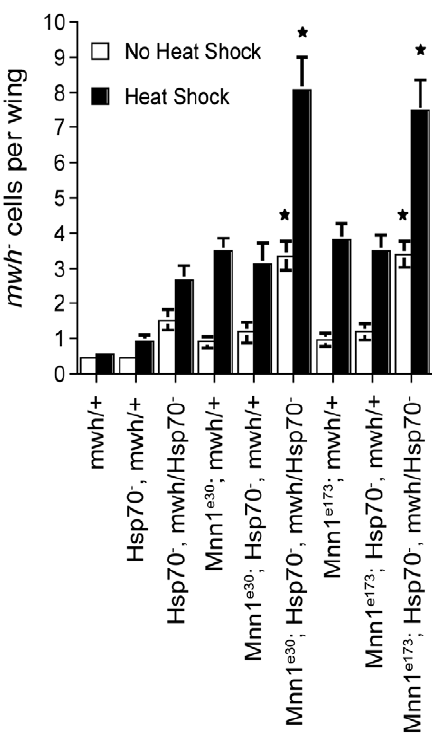
Figure 3. LOH in Mnn1 deletion mutants is not attributable to the disruption of Hsp70 expression. The mwh assay was used to assess genomic instability in Mnn1 deletion mutants ( Mnn1 e30 and Mnn1 e173 ) harboring half of the Hsp70 gene copy number or none. Both in the absence of stress or under short, repeated heat shock conditions, a reduction of the Hsp70 gene complement by half ( Mnn1 e30 ; Hsp70 - , mwh / + and Mnn1 e173 ; Hsp70 - , mwh / + ), did not result in a significant increase in the incidence of mwh - cells and did not augment the LOH observed in Mnn1 null flies ( Mnn1 e30 ; mwh / + and Mnn1 e173 ; mwh / + ) (p . 0.05). In contrast, under both normal lab and heat shock conditions, the complete loss of Hsp70 genes ( Mnn1 e30 ; Hsp70 - , mwh / Hsp70 - and Mnn1 e173 ; Hsp70 - , mwh / Hsp70 - ) significantly enhanced the LOH in Mnn1 deletion mutants (p , 0.05). The average number of mwh - cells per wing is indicated. Error bars represent SEM. Stars denote significant differences compared to Mnn1 null flies ( Mnn1 e30 ; mwh / + or Mnn1 e173 ; mwh / + ), p ,